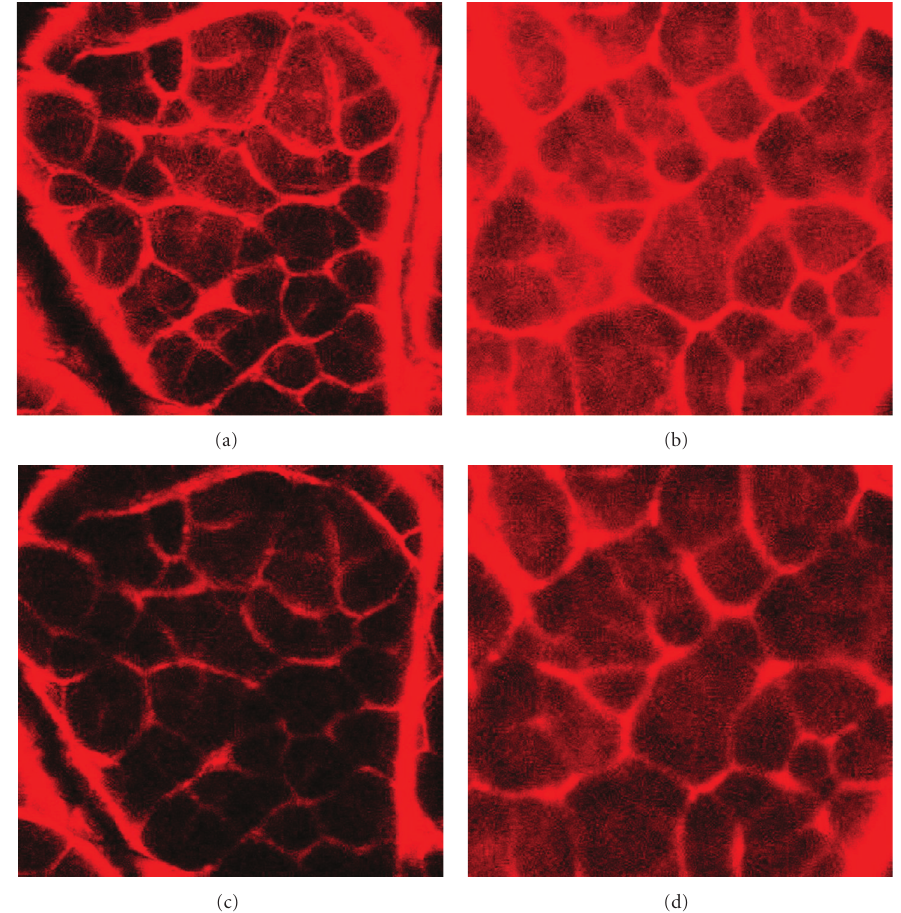
Figure 6: 2-photon fluorescent microscopy images showing skin barrier condition after treatment with NUG facial cleanser, with HMP (a and c) compared to CGSC (b and d) at a depth into the SC of 2 µ m (upper row; a and b) and 20 µ m (lower row; c and d). The limited dye penetration (lower intensity) indicates a more intact barrier, while more dye penetration indicates a weaker